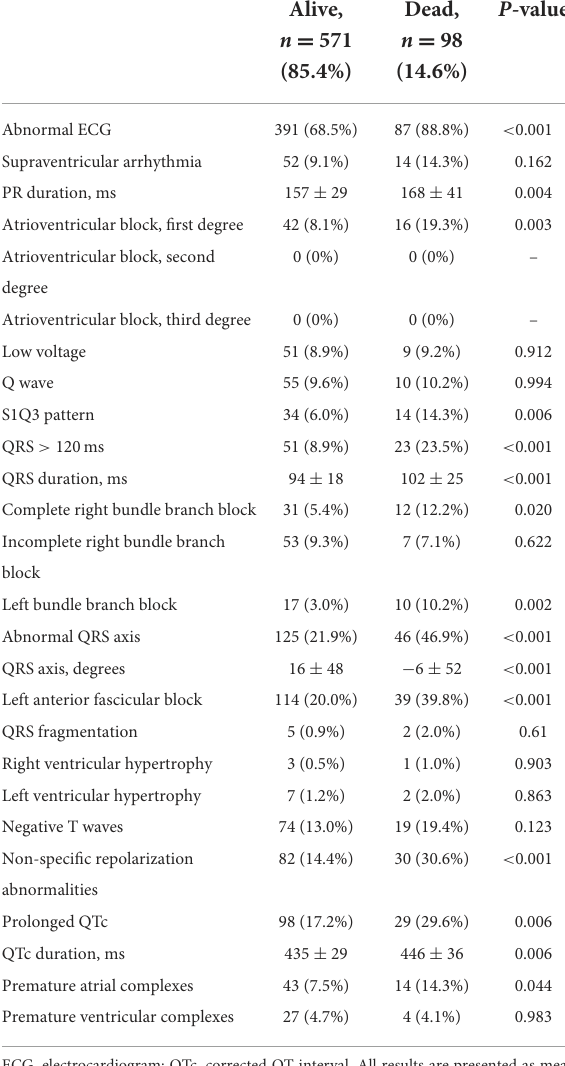
TABLE 3 Multivariate analysis for identifying variables at admission independently associated with